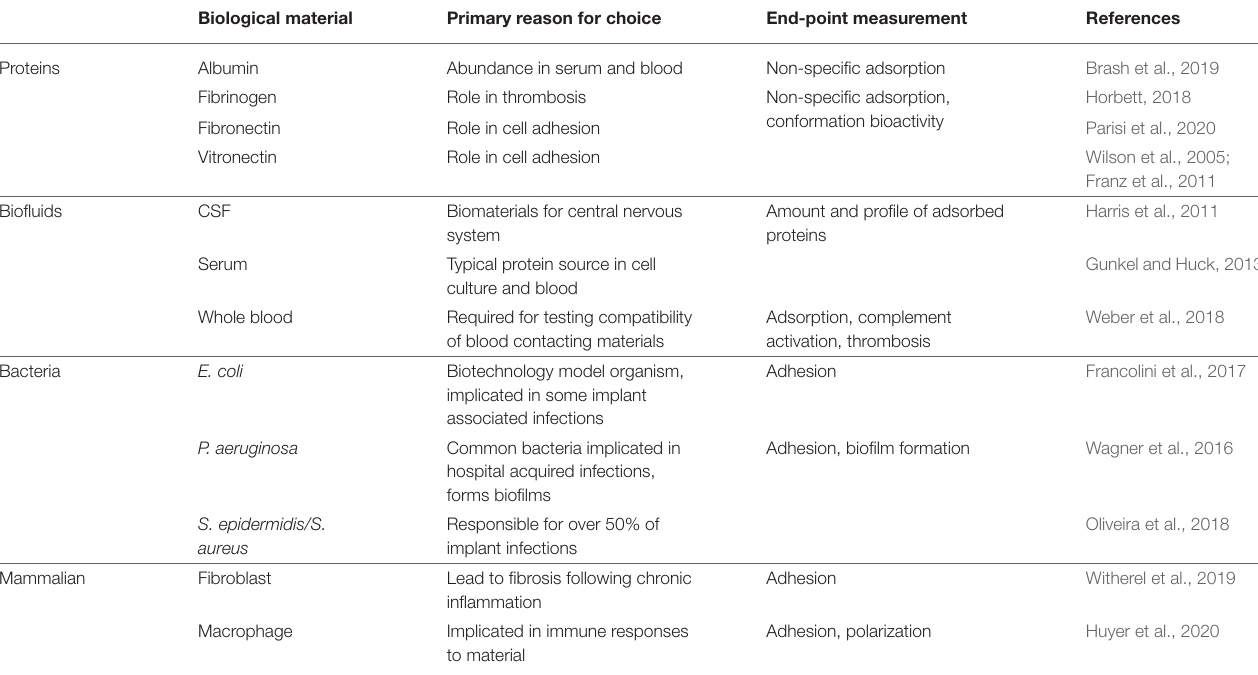
TABLE 1 | Biological materials commonly used for biofouling characterization with respect to endpoint